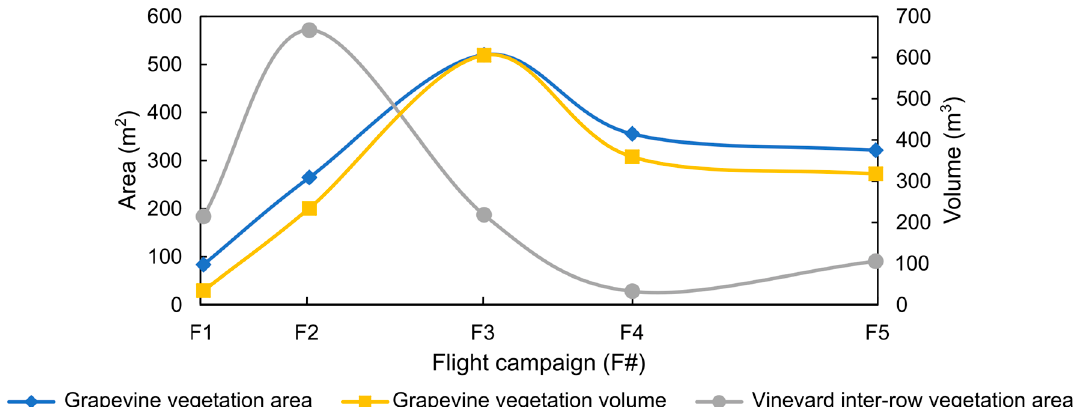
Figure 6. Estimated grapevines’ vegetation area and volume, and inter-row vineyard vegetation, in each flight campaign.